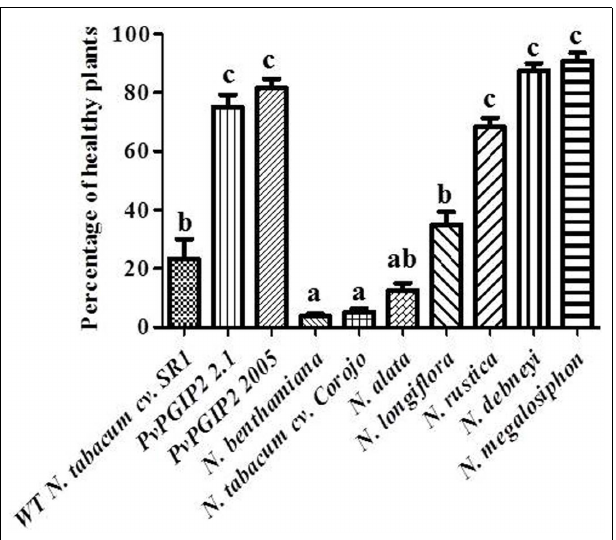
FIGURE 3 | Field trials of Pvpgip2 transgenic tobacco plants for resistance against P. hyoscyami f. sp. tabacina . Quantitative evaluation of resistance to P. hyoscyami f. sp. tabacina in different transgenic lines and reference genotypes. Nicotiana plants exhibiting different degree of natural resistance at 35 days after planting. Bars represent mean values with standard error ( N = 50). Columns designated with the same letter are not significantly different ( P >